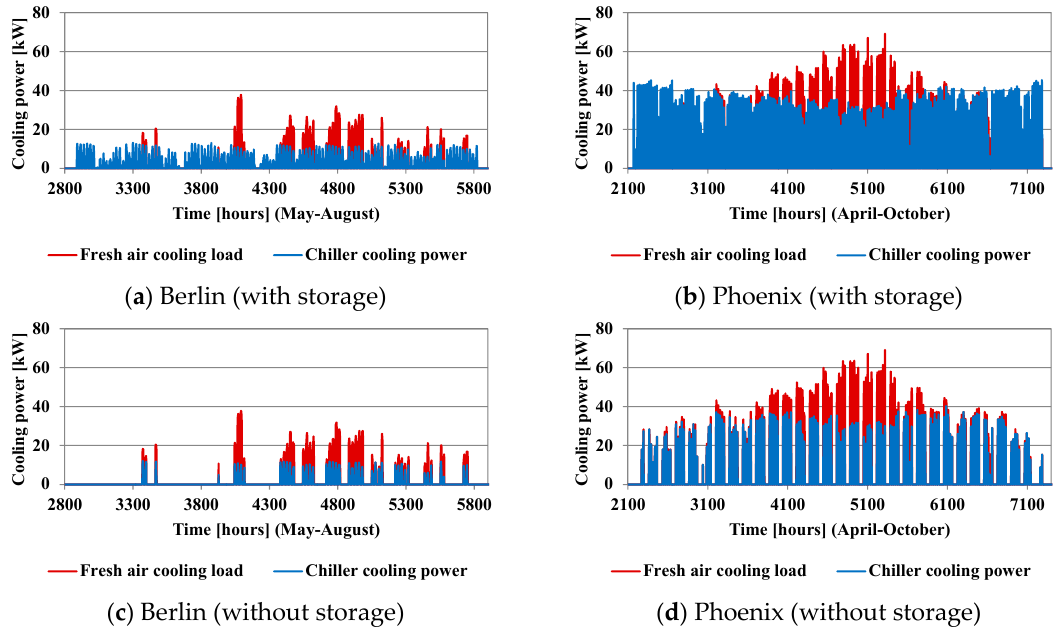
Figure 18. The cooling power with and without storage for two locations.